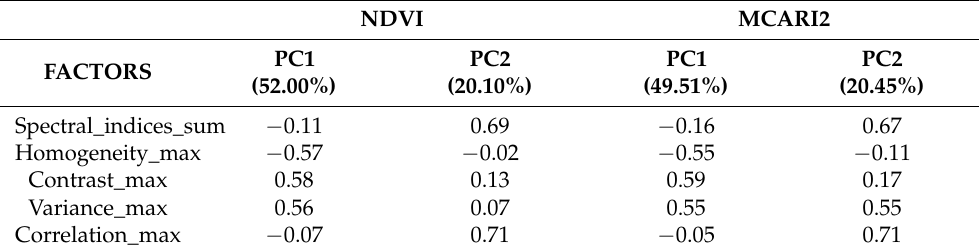
Table 6. Loadings of variables processed with the PCA.